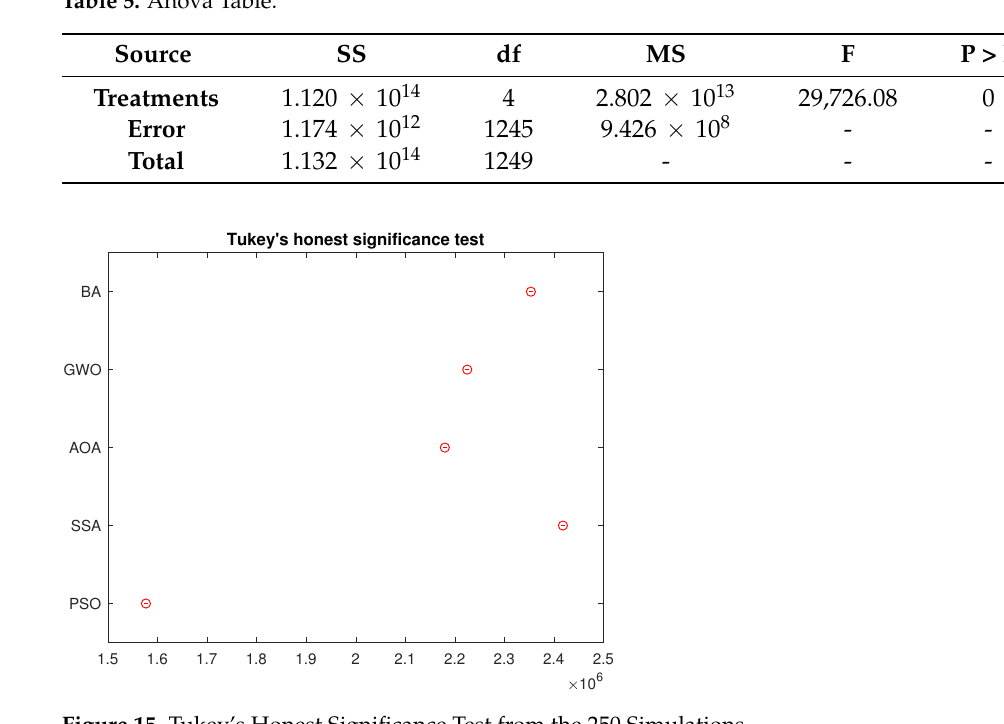
Figure 15. Tukey’s Honest Significance Test from the 250